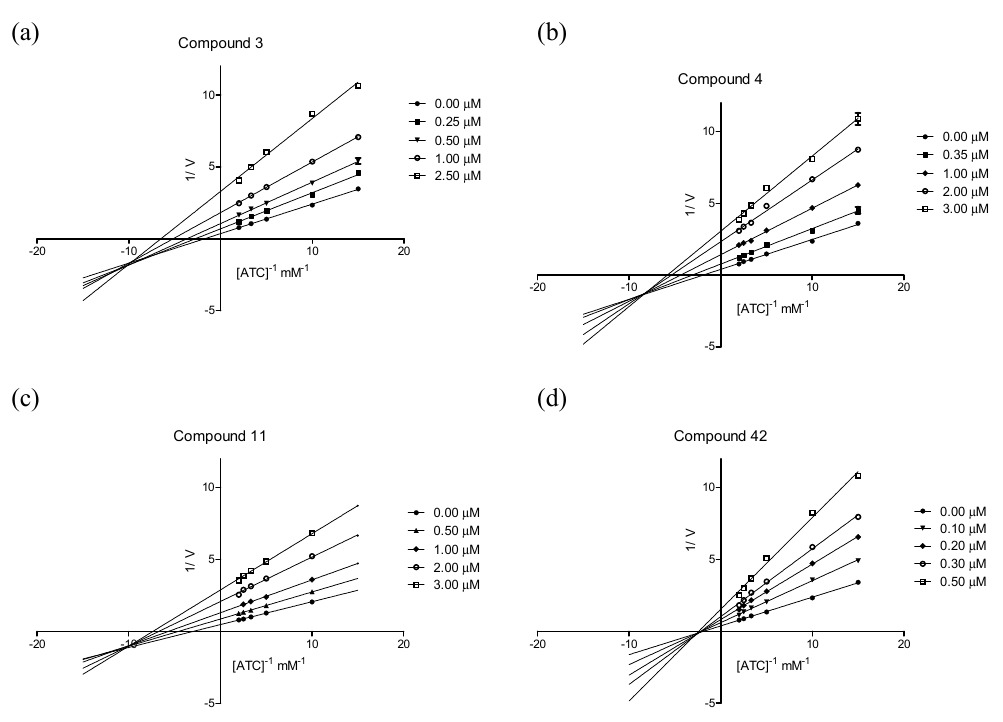
Figure 2. Lineweaver–Burk plots illustrating mixed type of Ee AChE inhibition by compounds 3 ( a ); 4 ( b ); 11 ( c ) and non-competitive type of Ee AChE inhibition by compound 42 ( d ). ATC = acetylthiocholine; V = initial velocity rate.